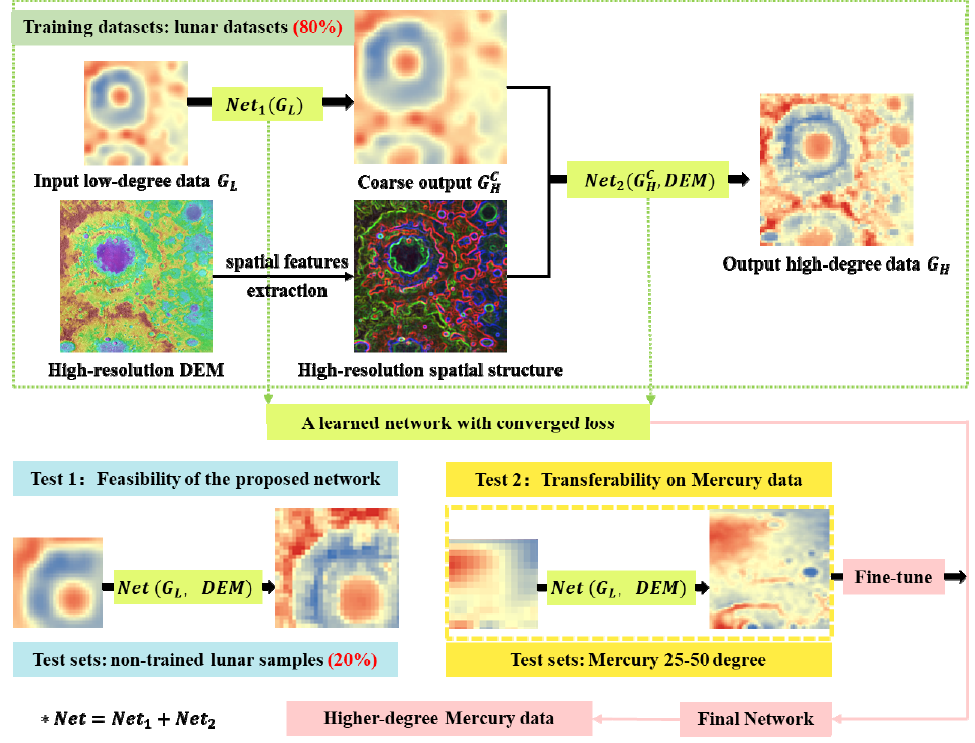
Figure 4. Flowchart of the proposed reconstructed network.